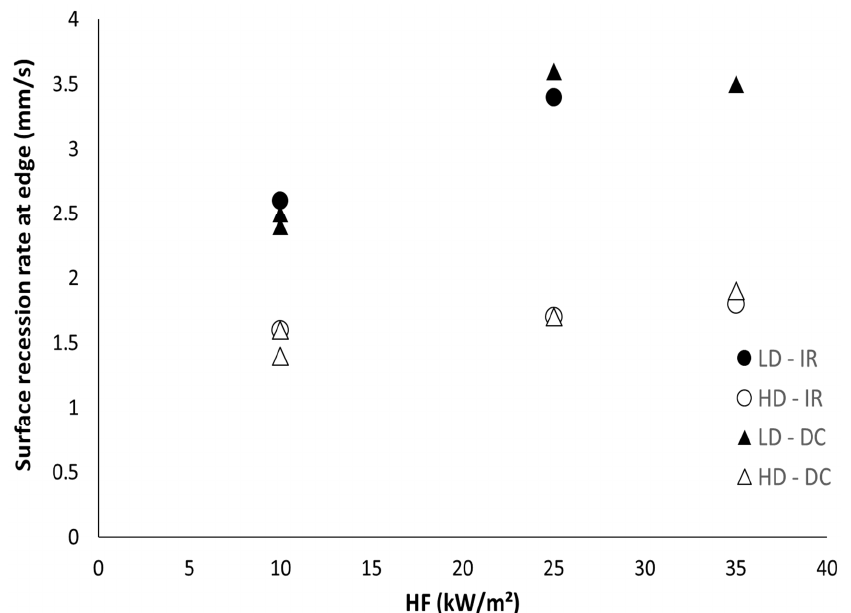
Figure 10. Evolution of the temperature front (measured by the IR camera) for the HD foam collapse during the cone calorimeter test at 35 kW/m 2 (sample thickness 10 cm)—The first point was fixed arbitrarily at 0 s and 0 cm.